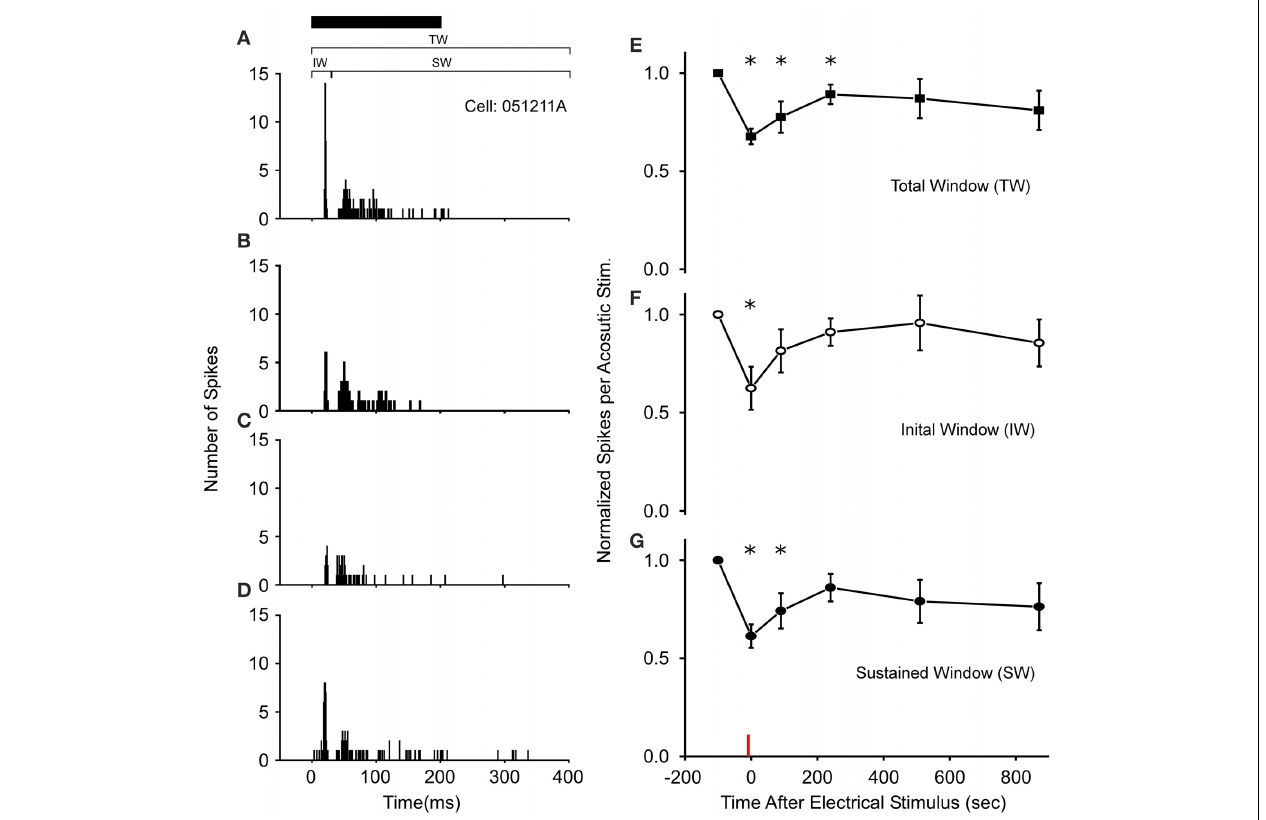
FIGURE 2 | Long-term thalamic stimulation decreases acoustic sensitivity for several minutes. (A) PSTHs of a cell’s response to a 200ms noise (black bar). Following 10s of electrical stimulation (2ms DC pulses, 20Hz, 6V) the number of spikes/acoustic stimulus in both the initial (IW) and sustained windows (SW) was reduced immediately (B) and after 90s (C) .